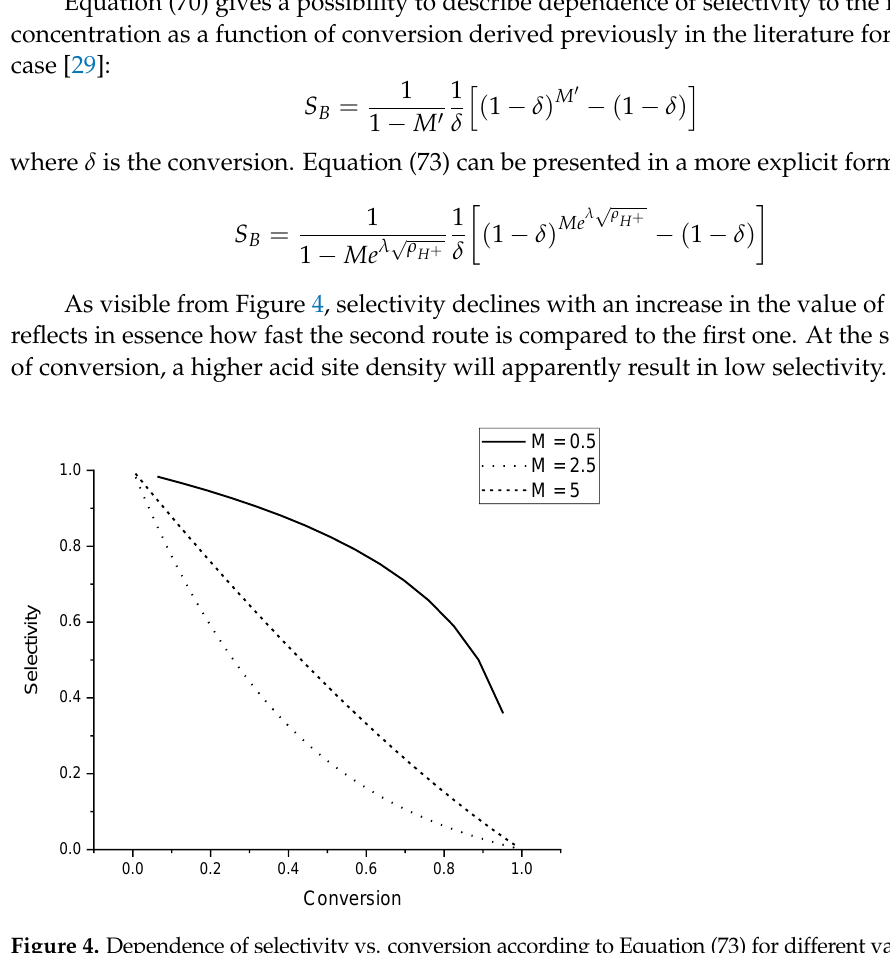
Figure 4. Dependence of selectivity vs. conversion according to Equation (73) for different values of M ’.